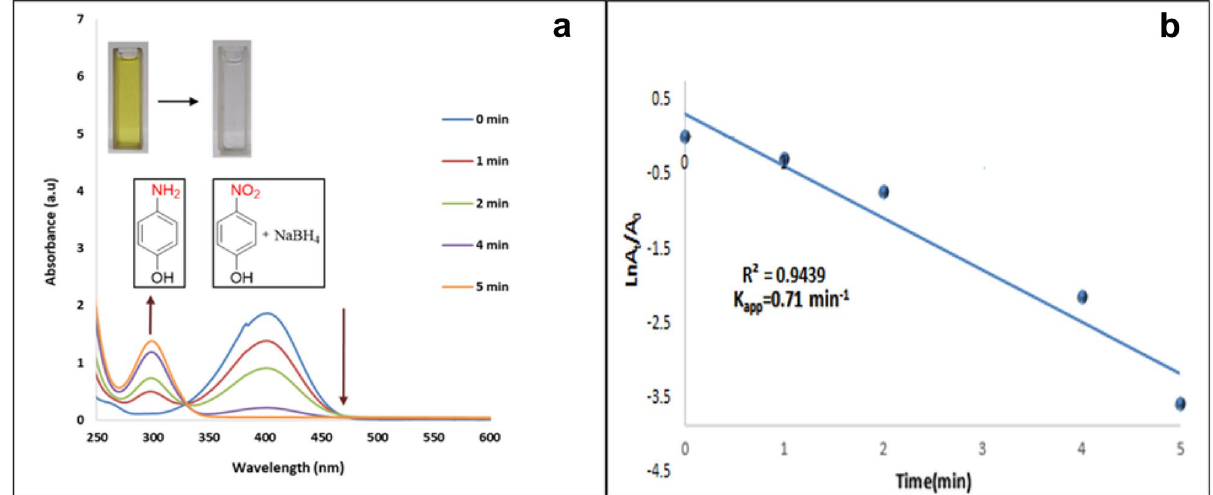
Figure 4. ( a ) UV–Visible spectra of the reduction of p -AP (0.5 mmol) over n-HA/Si-PA-SC@Ag (30 mg) and